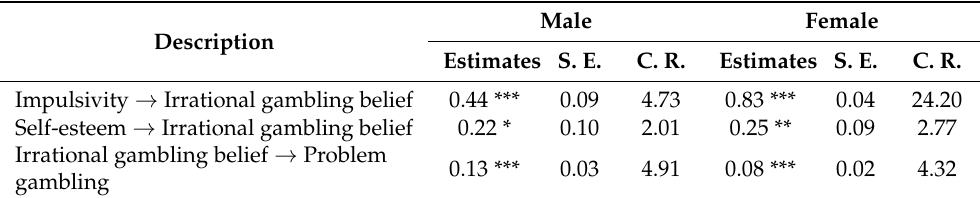
Table 8. Unstandardized estimates and standard errors of structural parameters in the two groups.